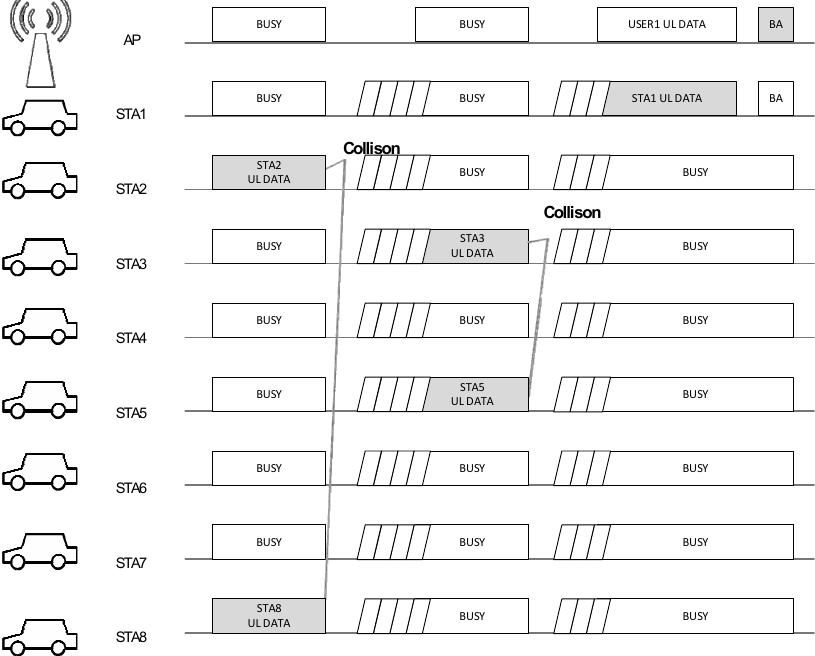
Figure 3. Channel collision in dense scenario of V2X.